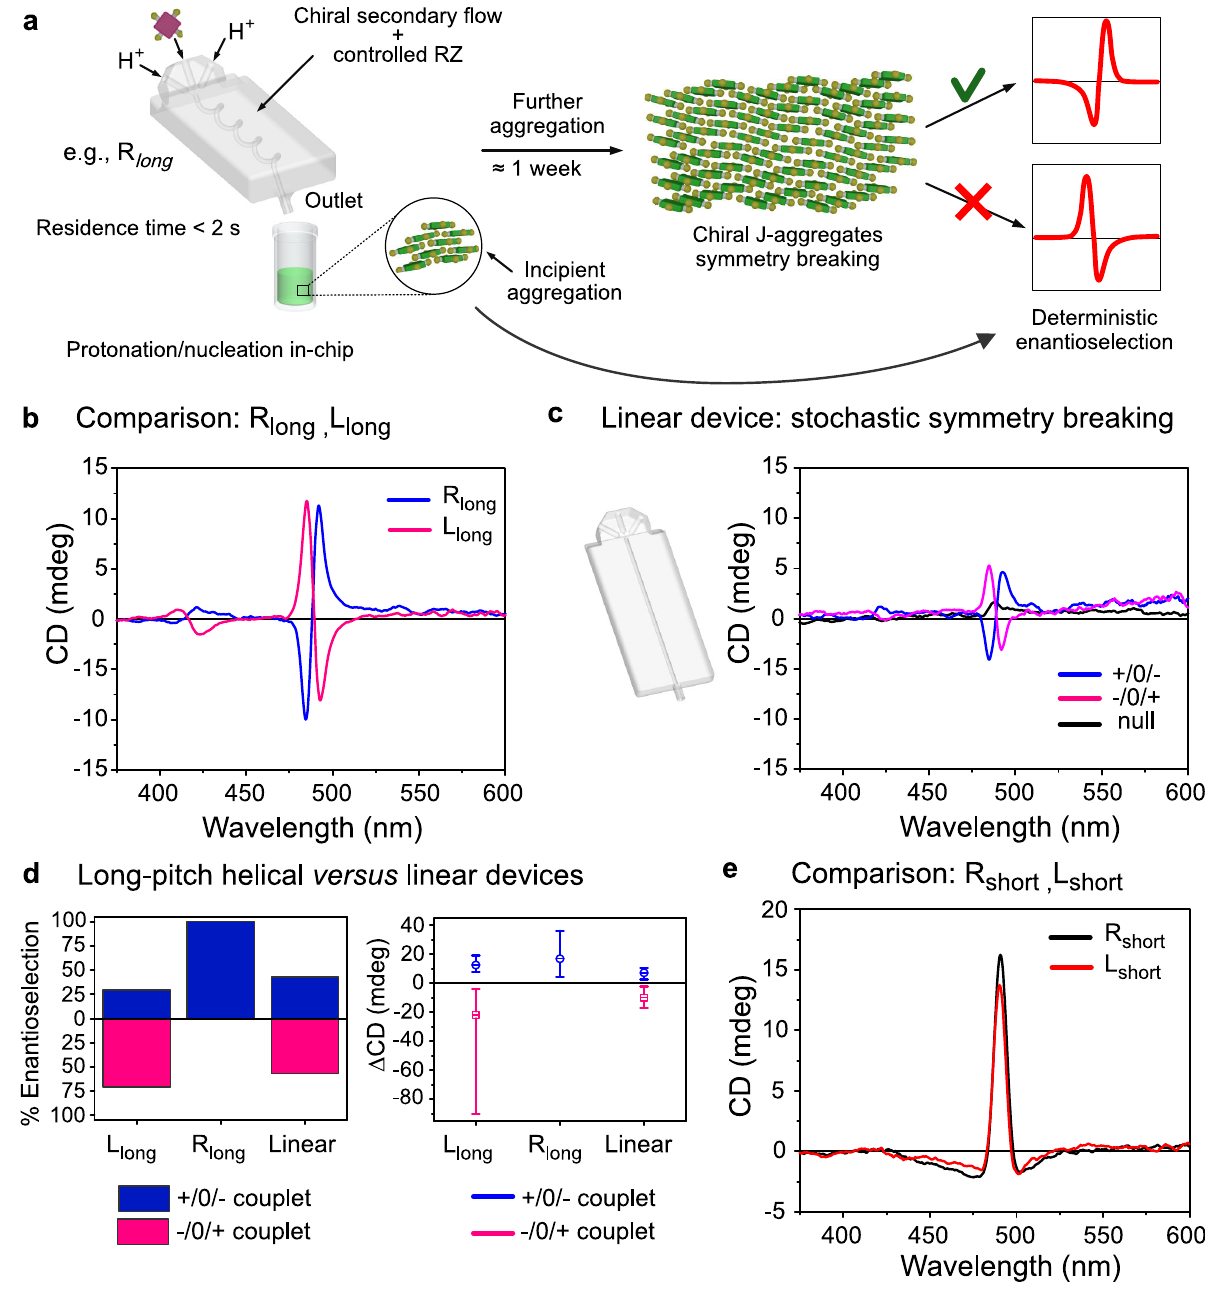
Fig. 4 Enantioselection in TPPS 3 J-aggregate formation: overview of the experimental results. a Schematic representation of the experimental procedure and of the deterministic enantioselection observed when using R long (or L long ) device. Mixing of the reactants, porphyrin protonation and aggregate nucleation occur during the short residence time in-chip (<2 s). Further aggregation and the appearance of CD bands occur overtime off-chip. b Representative CD spectra showing the opposite enantioselection obtained when using R long and L long devices. c Representative CD spectra obtained in the case of the experiments performed with the Linear device (stochastic symmetry breaking). d Left: stacked histogram representing the percentage of positive (blue) and negative (pink) CD couplets obtained when using L long , R long and Linear micro fl uidic devices. Right: distribution of the peak-to-peak amplitudes for the positive (blue) and negative (pink) CD couplets observed in the same experiments. The centre of the squares indicates the average amplitude, the vertical bars represent the spreading of the amplitude values. e Representative CD spectra obtained in samples prepared with R short (black) and L short (red) devices showing trisignate